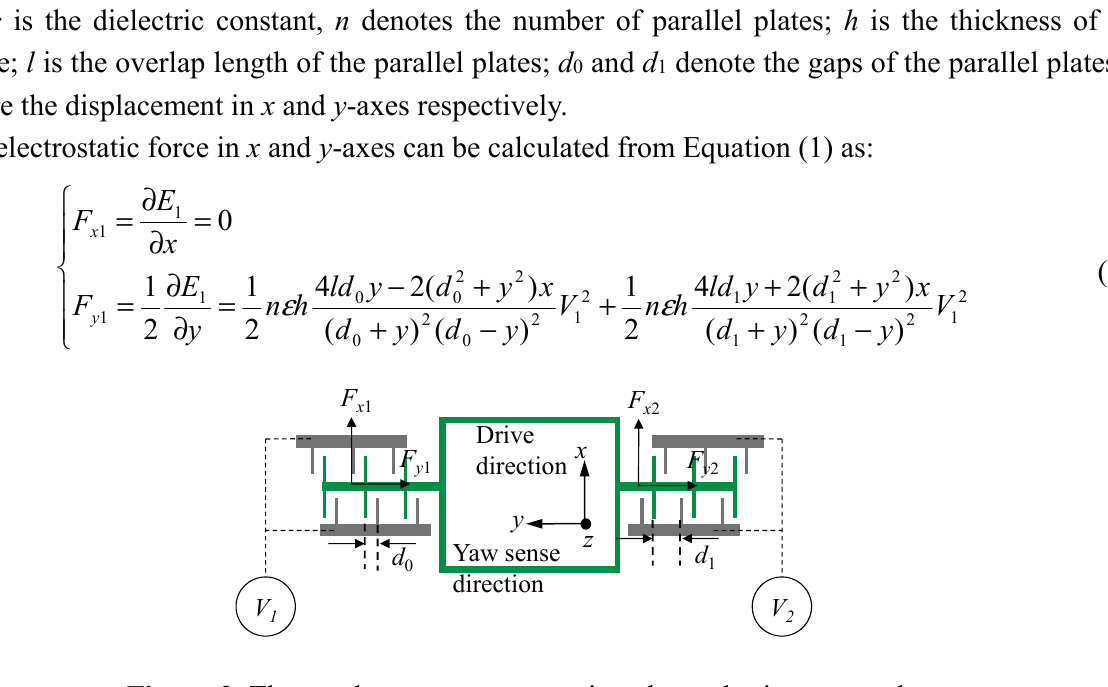
Figure 3. The quadrature error correction electrodes in yaw